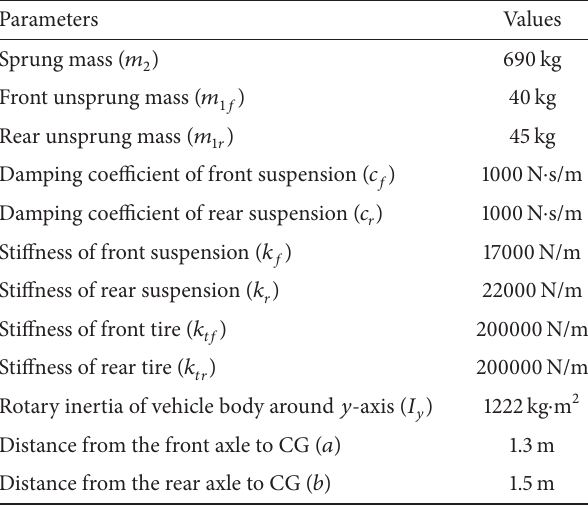
Table 1: Parameters of 4-DOF active